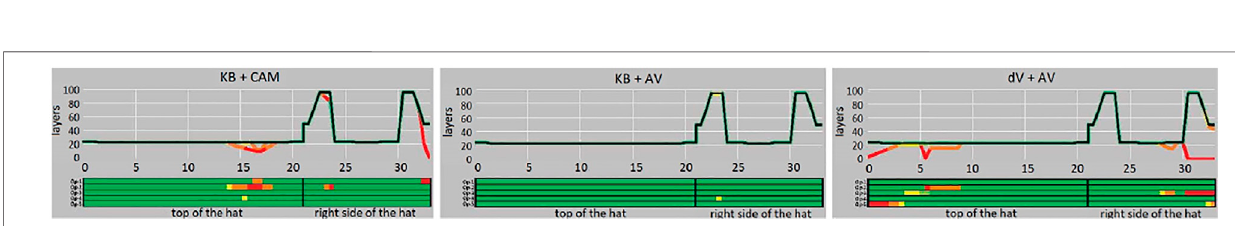
FIGURE 11 | Soft-MLI setup for cutting MLI hat. (A) remote robot with satellite; (B) Closeup of cutting assembly on UR10 robot.